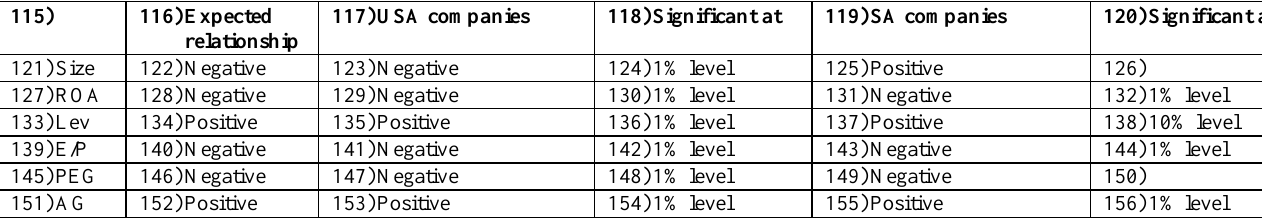
Table 10: Comparison – other variables: Three-year growth period